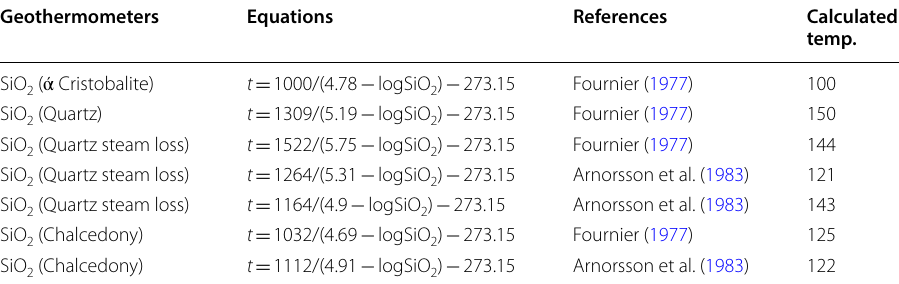
Table 5 Estimated reservoir temperatures (°C) for the Şavşat thermal waters using silica geothermometers (SiO 125.8 2 =